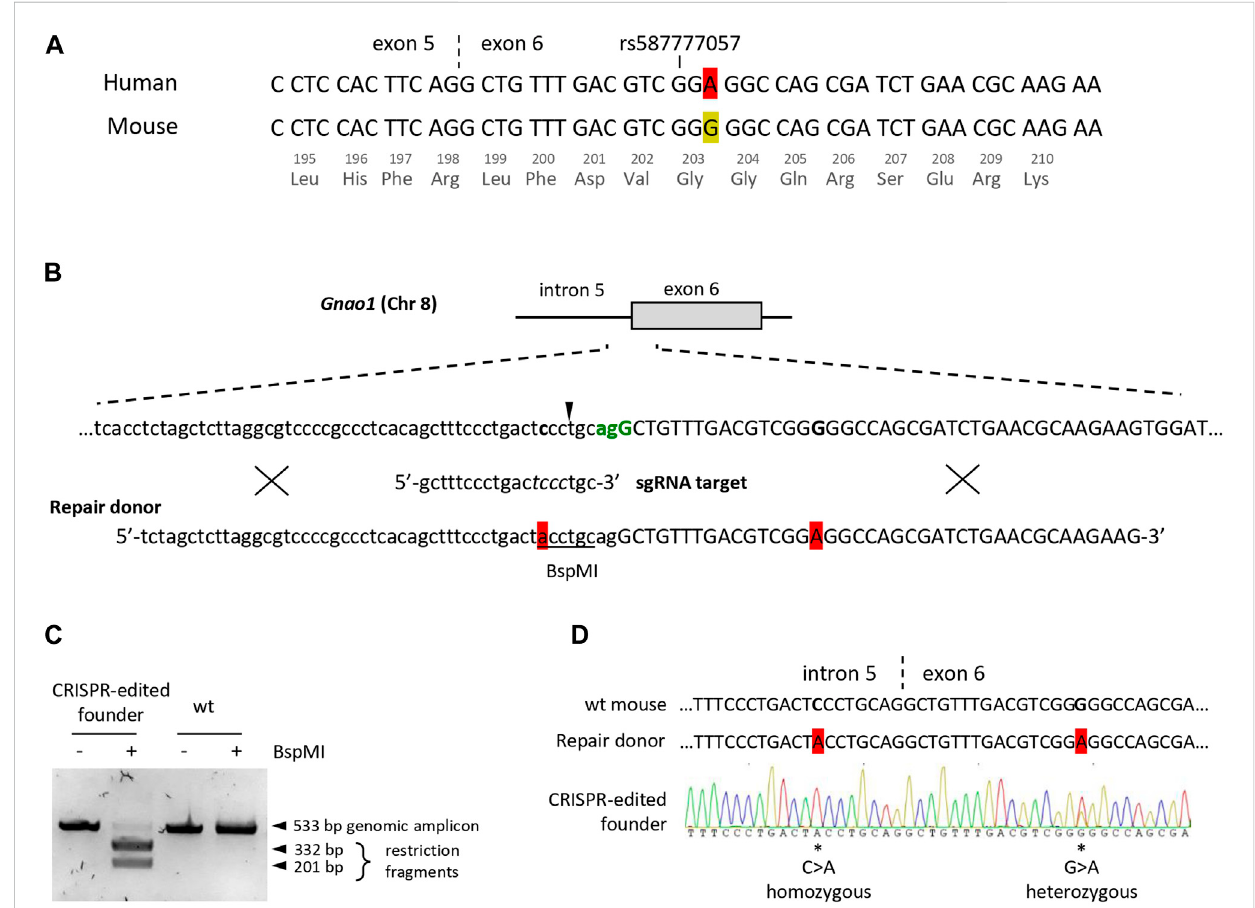
FIGURE 1 Creation of the founder mouse with the “ humanized ” fragment of the Gnao1 using CRISPR/Cas9. (A) Sequence alignment of the human (NM_ 020988.3) and the mouse (NM_010308.3) Gnao1 transcripts at the exon 5 - exon 6 junction (marked with dash line), ±25 nucleotides around the human polymorphism rs587777057 are shown. A single synonymous variation in Gly203-coding triplet is highlighted in red for A and yellow for G in human and mouse transcripts, respectively. (B) Graphical representation of the Cas9/sgRNA-assisted homologous recombination in mouse Gnao1 gene using ssODN+ as a repair template. The genomic sequence of the intron 5 (lowercase) and exon 6 (uppercase) junction is shown. The PAM site for Cas9 ( S.pyogenes ) is in green and coincides with the 3 ′ splice site. An arrowhead indicates Cas9 cut site (3-nt upstream of the PAM site). Below is the sgRNA target sequence; mismatch-sensitive “ core ” sequence (positions +4 to +7 upstream of PAM according to (Zheng et al., 2017) in italic. Two nucleotides subjected to substitution in the Gnao1 genomic sequence are in bold. ssODN+ (90 nt) is with two single-base substitutions highlighted in red, BspMI site is underlined. Crosses schematically demonstrate putative homology-directed repair. (C) Genotyping of the CRISPR/Cas9-edited founder mouse at P10 by restriction analysis. The genomic DNA fragment (533 bp) encompassing the Cas9 cleavage site was ampli fi ed from the tissue biopsy. Amplicon digestion with BspMI con fi rms the presence of ssODN-mediated knock-in in the mouse genome. (D) Sanger sequencing chromatogram of genomic DNA from the CRISPR/Cas9-edited founder mouse. Two single-base substitutions are marked by asterisks and their position in the genome is speci fi ed. Sequences of the wt mouse and ssODN are shown for